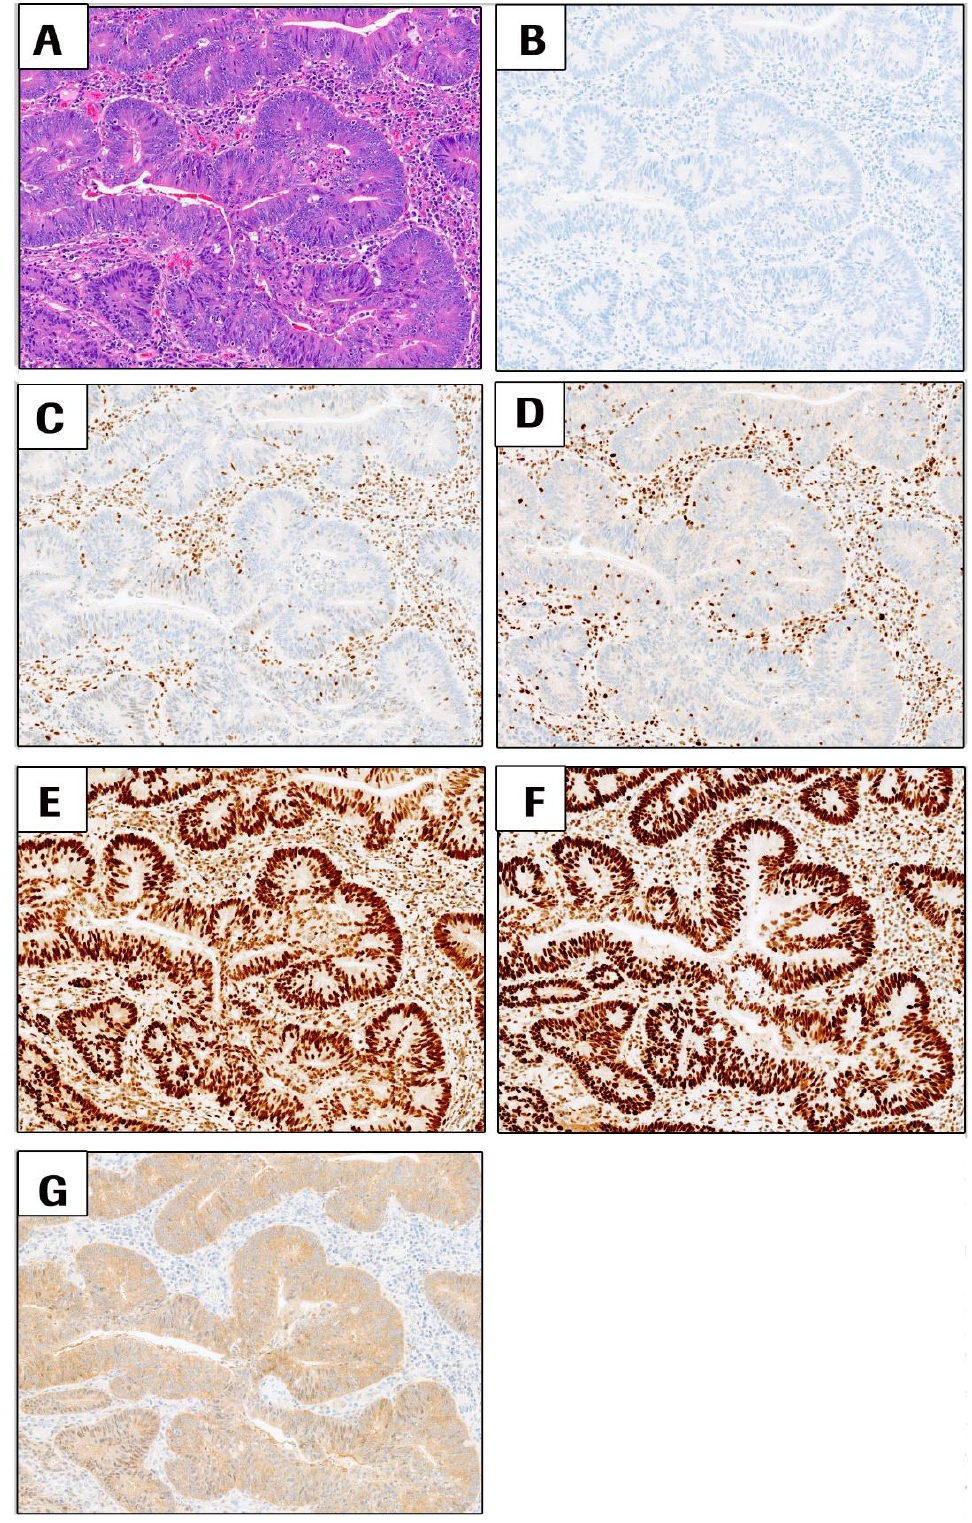
Figure 3. Representative images of sporadic CRC cases with deficient DNA mismatch repair status (dMMR) due to loss of MLH1 and PMS2 with intact MSH2 and MSH6. BRAF V600E is positive in this case. All images are at 10× magnification. ( A ) H&E, ( B ) negative control antibody, ( C ) MLH1, ( D ) PMS2, ( E ) MSH2, ( F ) MSH6, and ( G ) BRAF V600E staining (positive signal = brown cytoplasmic staining in tumor cells). All images are at 10× magnification. Pooled agreement between IHC and molecular testing for all MMR markers and BRAF V600E: IHC status was compared with results from molecular testing which in- cluded sequencing and hypermethylation testing (if appropriate) to determine pooled PPA and NPA for all four MMR markers and BRAF V600E. The point estimate for PPA